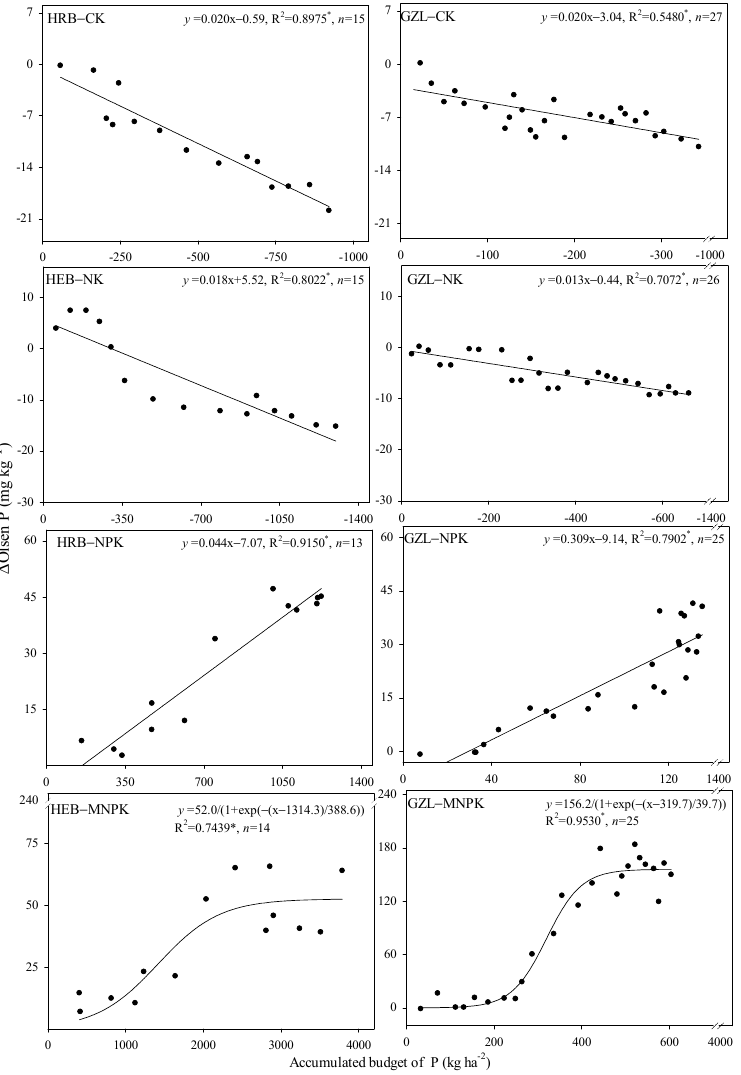
Figure 3. Relationship between Δ Olsen P and different P budget. HRB and GZL are the abbrevia- tions of the names of long-term experiment sites, which are located in Harbin and Gongzhuling in China. CK, no fertilizer or manure; NK, nitrogen and potassium; NPK, nitrogen, phosphorus and potassium; MNPK, manure, nitrogen, phosphorus and potassium. The fitting equation of MNPK is y = A/(1 + exp ( − (x − x 0 )/b)), “A” represents the equilibrium value, * p < 0.05, “ n ” represents the num- ber of samples.